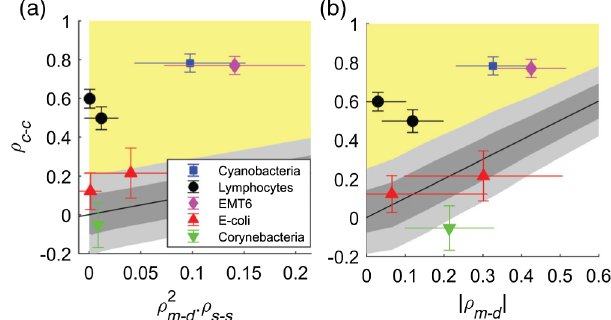
FIG. 2. Measured correlation coefficient in lineages. (a) Plot of the correlations in cell-cycle duration between cousin cells ( ρ c − c ) versus ρ 2 m − d × ρ s − s . The diagonal line corresponds to Δ ¼ 0 . Data points in the yellow area are those with Δ significantly above zero (p-value < 0 . 05 ), i.e., where Eq. (6) does not hold. (b) The same data as in (a), plotted as the correlations in cell-cycle duration between cousin cells versus j ρ m − d j . Data points in the yellow area are those for which the cousin-mother inequality holds [Eq. (8)]. The grey areas mark correlation values that could result from a random process within one (dark grey) or two (light grey) standard deviations from the diagonal line (see Sec.